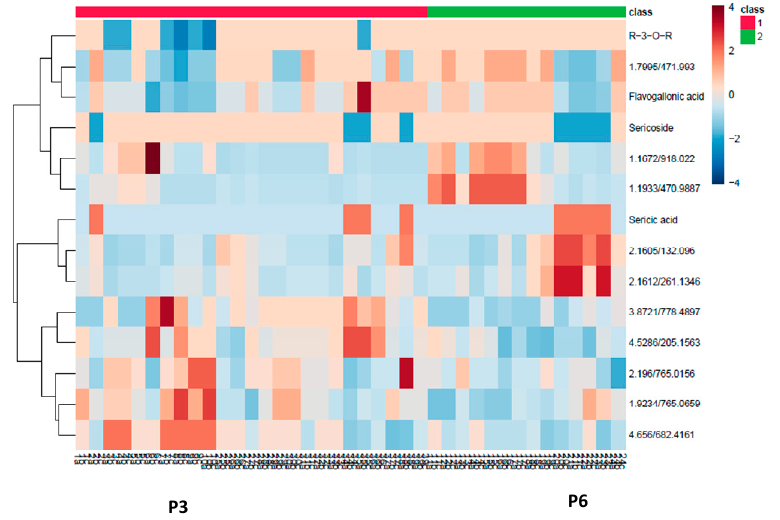
Figure 4. Heatmap of 15 VIP peaks in 39 samples of T. sericea root bark tested against S. typhi . R-3- O -R: resveratrol-3- O - β -rutinoside.